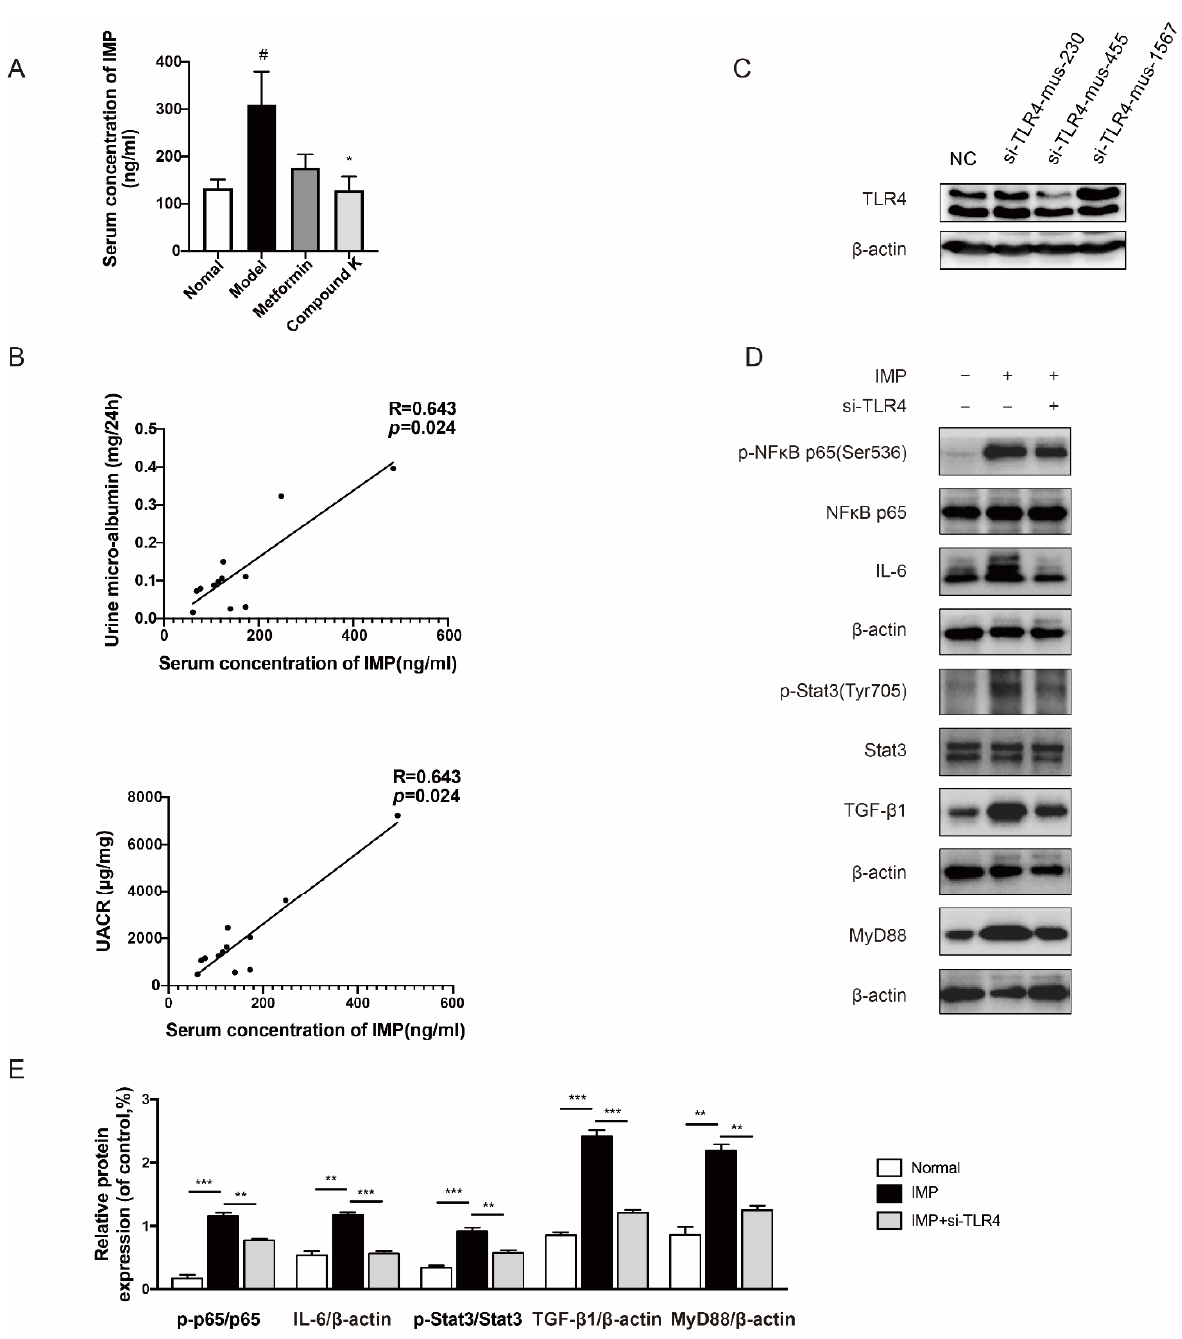
Figure 3. CK supplementation reduced microbial metabolite IMP as a TLR4 agonist related to proteinuria in DKD. ( A ) Serum levels of IMP in mice. Data were expressed as means ± SEM ( n = 7). # p < 0.05 compared to normal. * p < 0.05 compared to model. ( B ) Positive correlation between serum levels of IMP and urine levels of microalbumin and UACR. ( C ) The protein expression of TLR4 was detected with or without siRNA for TLR4. ( D ) The levels of phospho-NF- κ B, -NF- κ B, IL-6, phospho- Stat3, Stat3, TGF- β 1, and MyD88 proteins were detected in mesangial cells by IMP pretreatment with or without siRNA for TLR4 (mus-455). ( E ) Data in ( D ) were expressed as means ± SEM ( n = 3). NC, negative control. *** p < 0.001, ** p < 0.01.